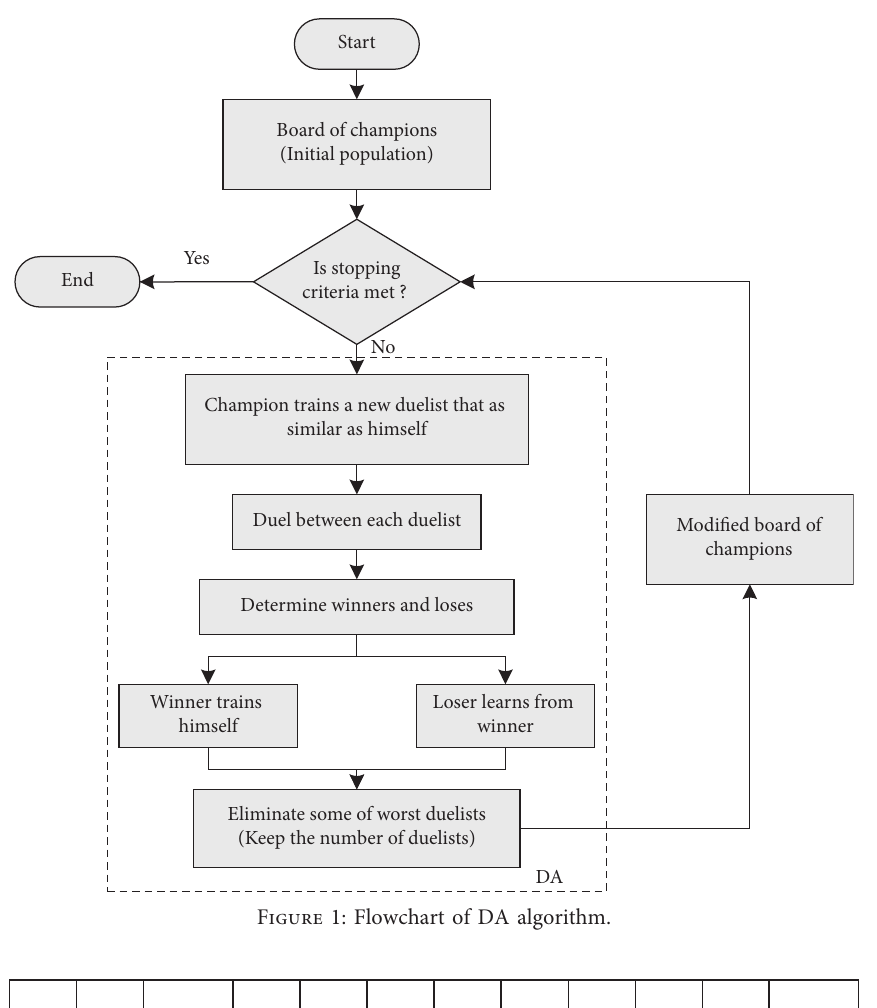
Figure 1: Flowchart of DA algorithm.